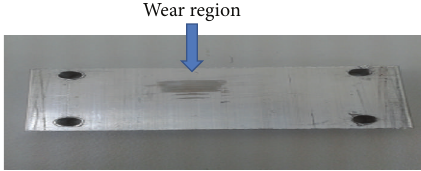
Figure 3: The wear region of a specimen.